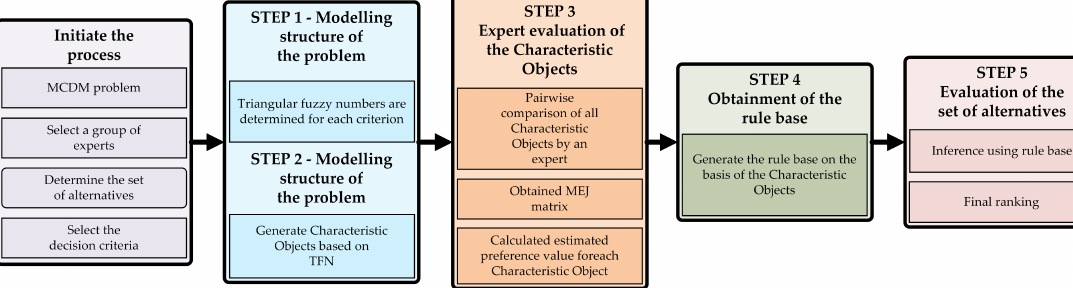
Figure 1. The procedure of the Characteristic Objects Method (COMET) to identify decision-making